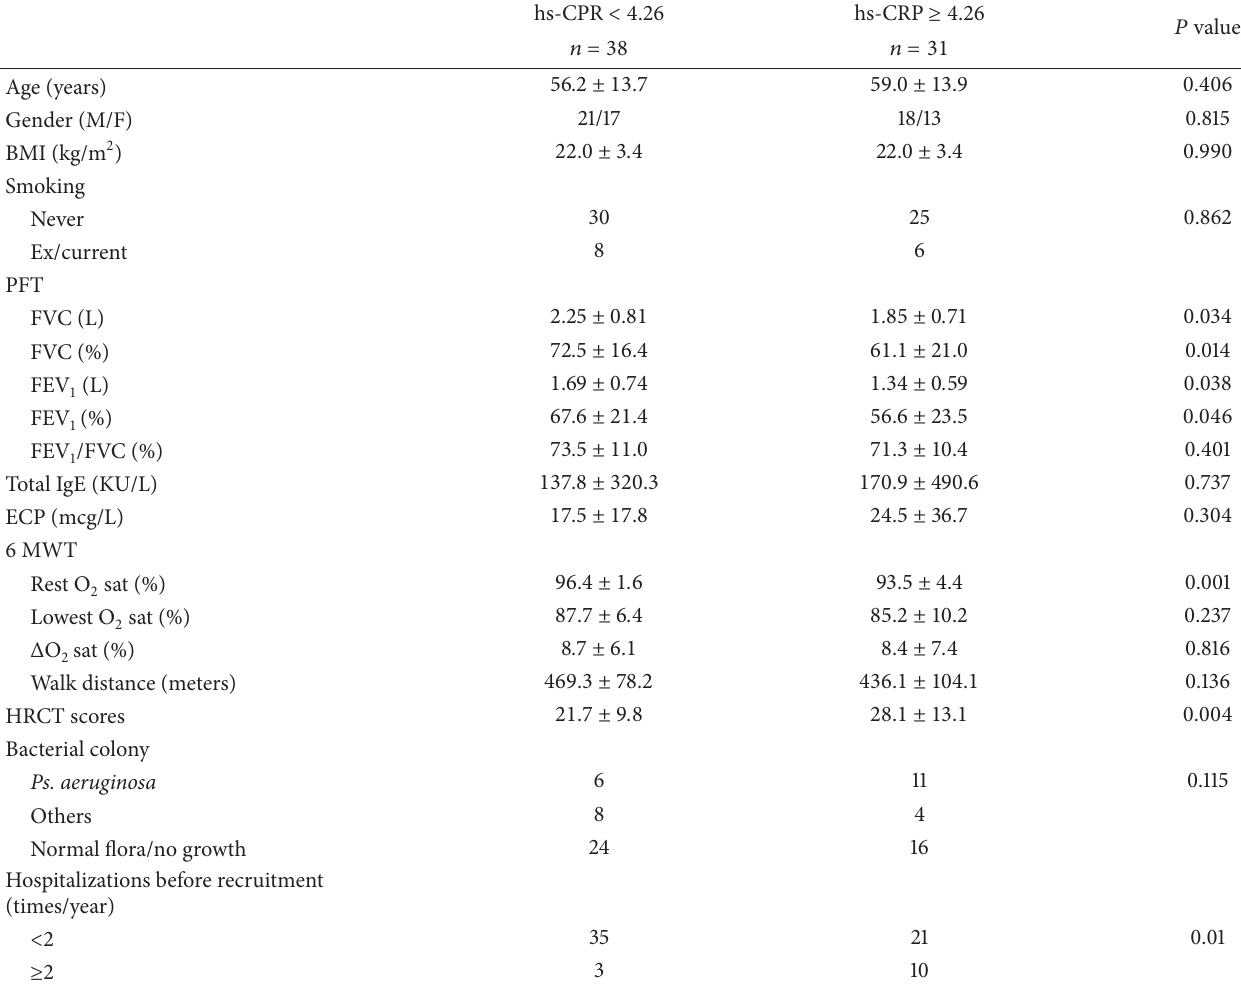
Table 2: Characteristics and outcomes of the 69 stable bronchiectasis